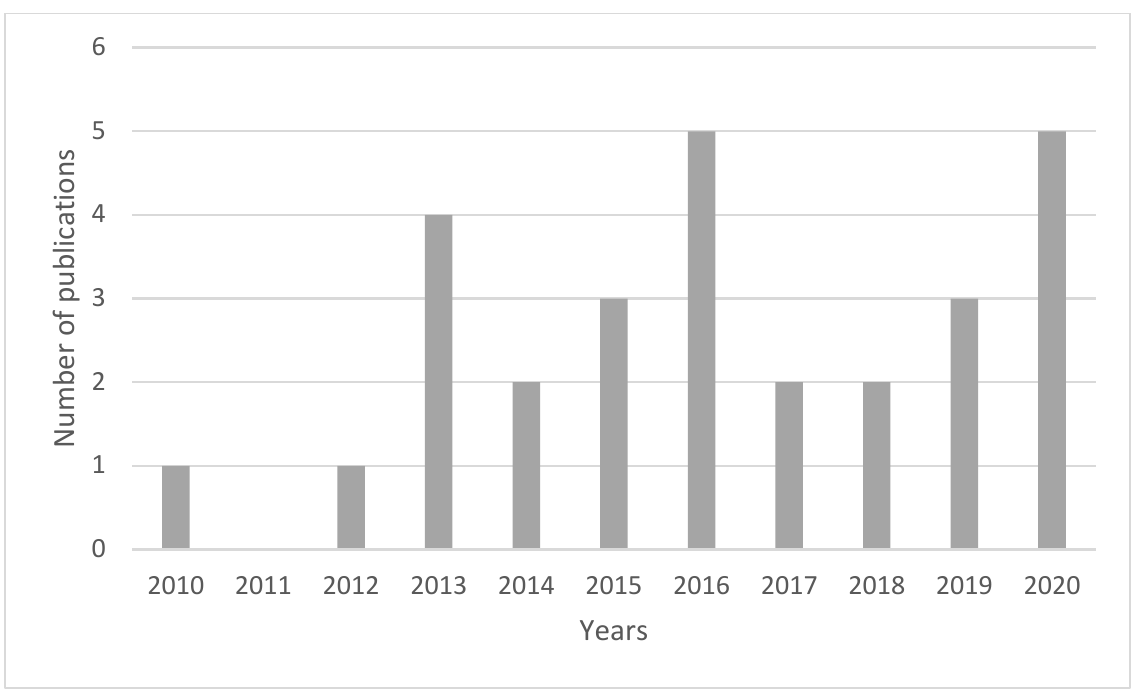
Table 3. Countries covered in existing studies (source: own elaboration).